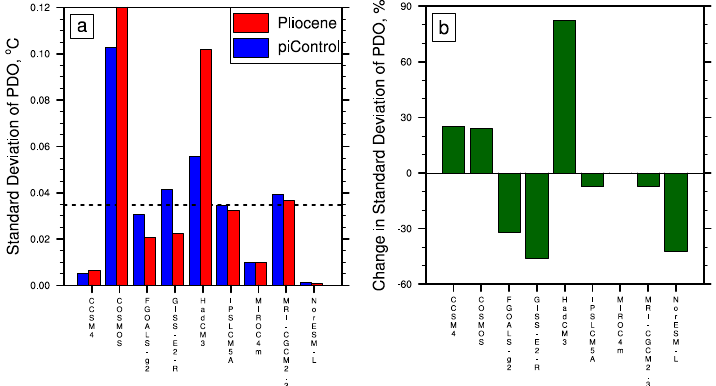
Figure 5. The standard deviations of Pacific Decadal Oscillation – defined as the first EOF of the North Pacific. The dashed line shows the standard deviation of the PDO in the ERSST